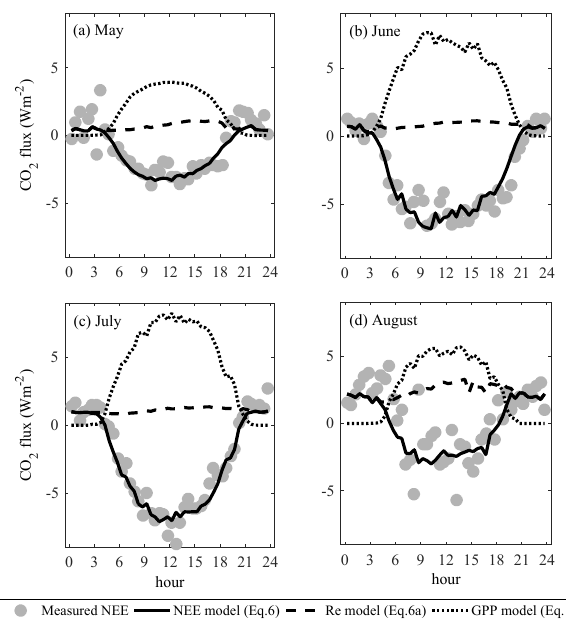
Figure 9. Mean diurnal course of NEE and its components for in- dividual months during the study period. The time on the x axis corresponds to local winter time (UTC +